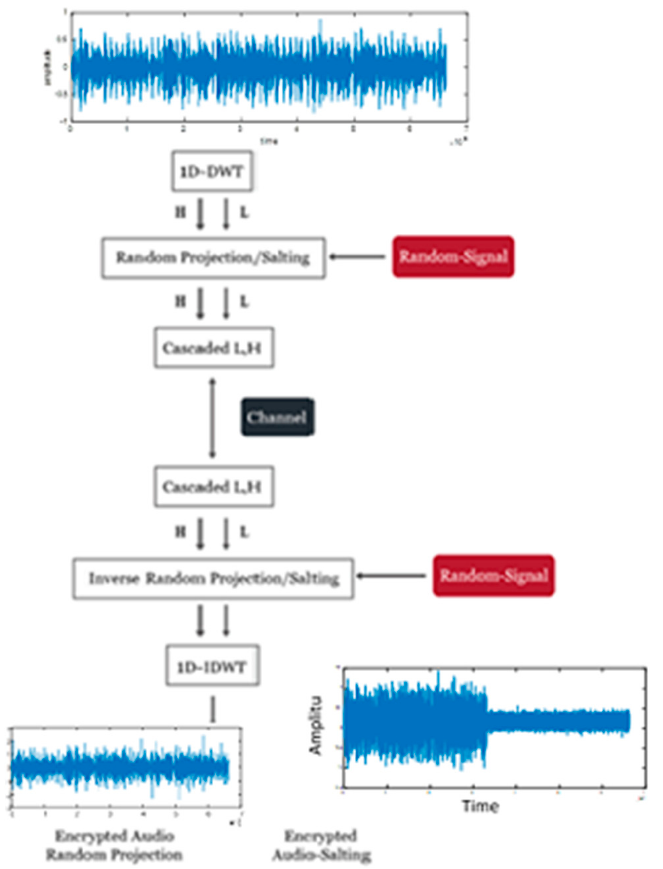
Figure 2. A 1D DWT fusion system for encryption with random projection and salting.